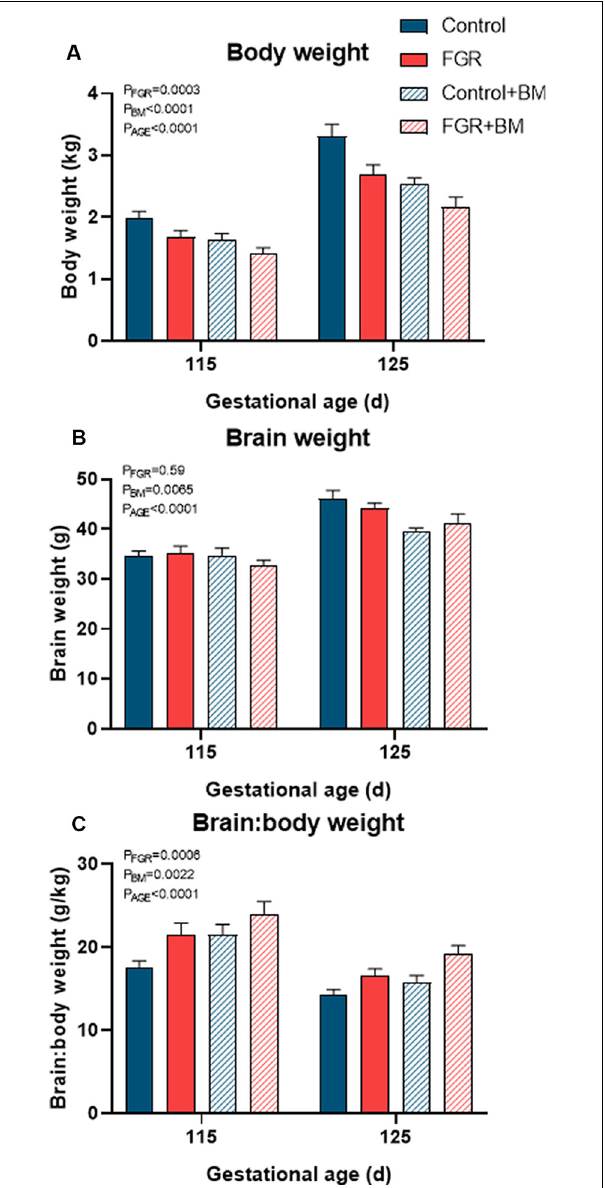
FIGURE 1 | Fetal weights at post mortem. Fetal body weight (A) , brain weight (B) and the brain: body weight ratio (C) at post mortem. Data are presented as mean ± SEM.